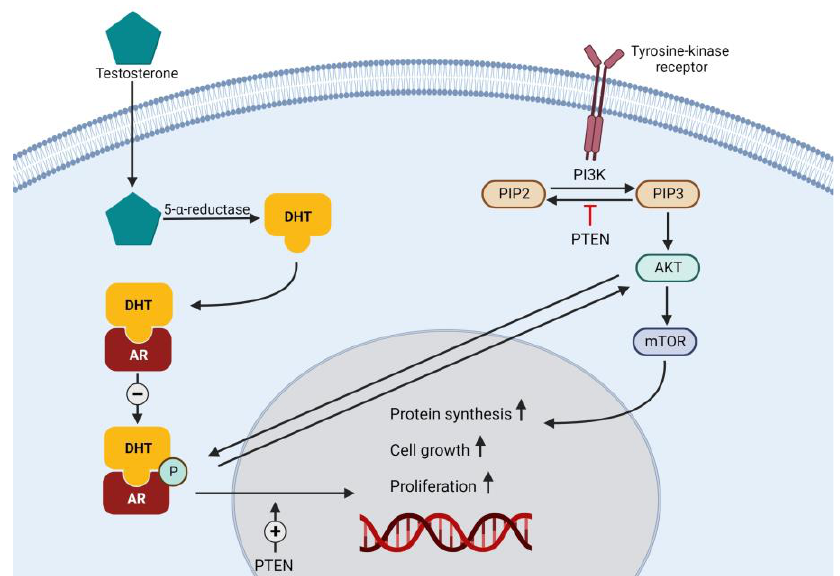
Figure 3. Simplified crosstalk between androgen receptor pathway and PI3K-AKT pathway. DHT = dihydrotestosterone; AR = androgen receptor; PI3K = phosphoinositide-3-kinase; PIP2 = phosphatidylinositol(3,4,5)-biphosphate; PIP3 = phosphatidylinositol(3,4,5)-triphosphate; PTEN = phosphatase and tensin homolog; AKT = protein kinase B; mTOR = mammalian target of rapamycin.